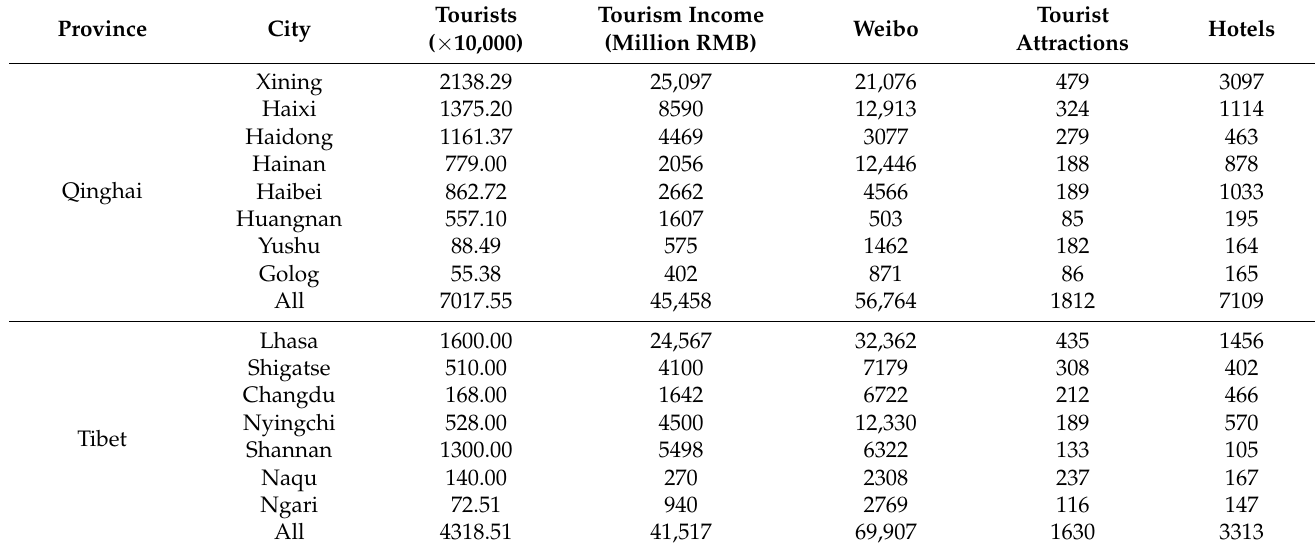
Table 5. Point data statistics of cities in Qinghai and Tibet